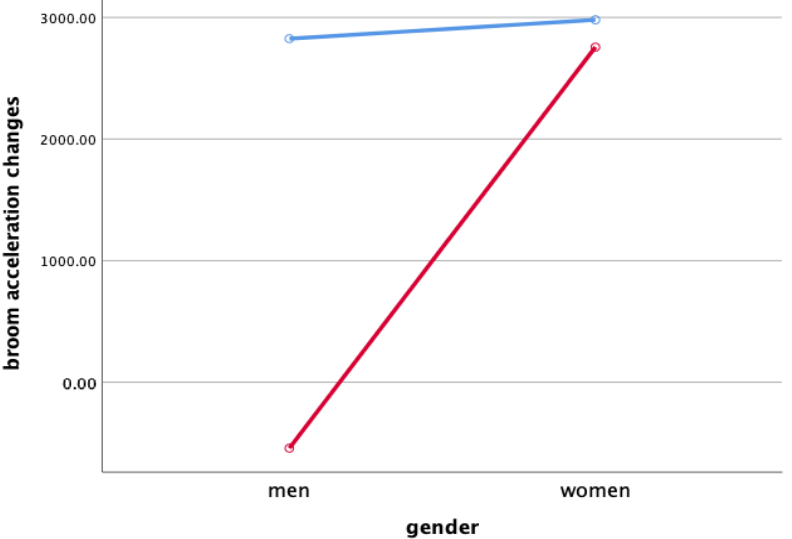
Figure 3. Broom Acceleration Changes When Sweeping(X)—interaction effect (mG). Red line: along the axis of motion, blue line: perpendicular to the axis of motion.